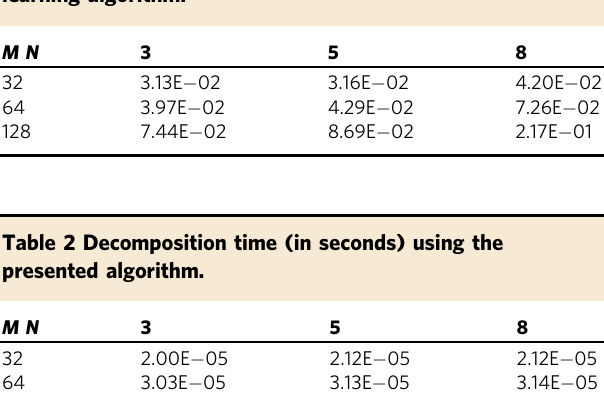
Table 1 Decomposition time (in seconds) using the deep learning algorithm.